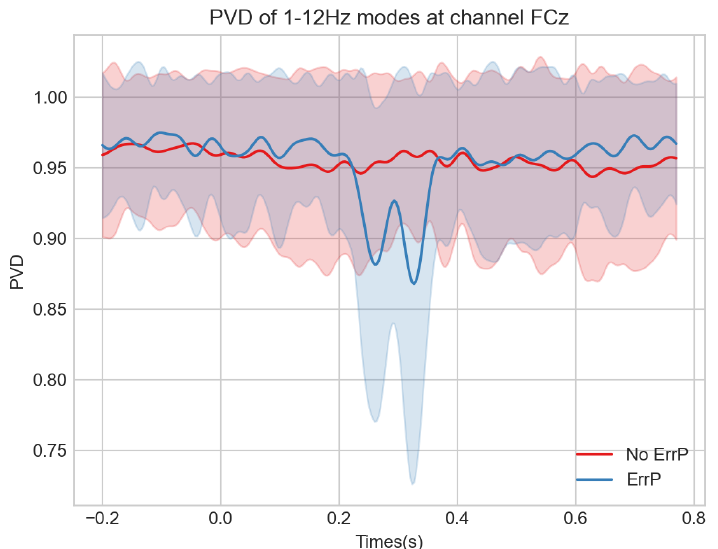
Figure 7. Phase consistency across different time evolutions of DMD modes within a single trial. ( a ) PVD. ( b ) IMPC. (Take the recording in session 2 of subject 3 in the monitoring error-related potentials dataset as an example).